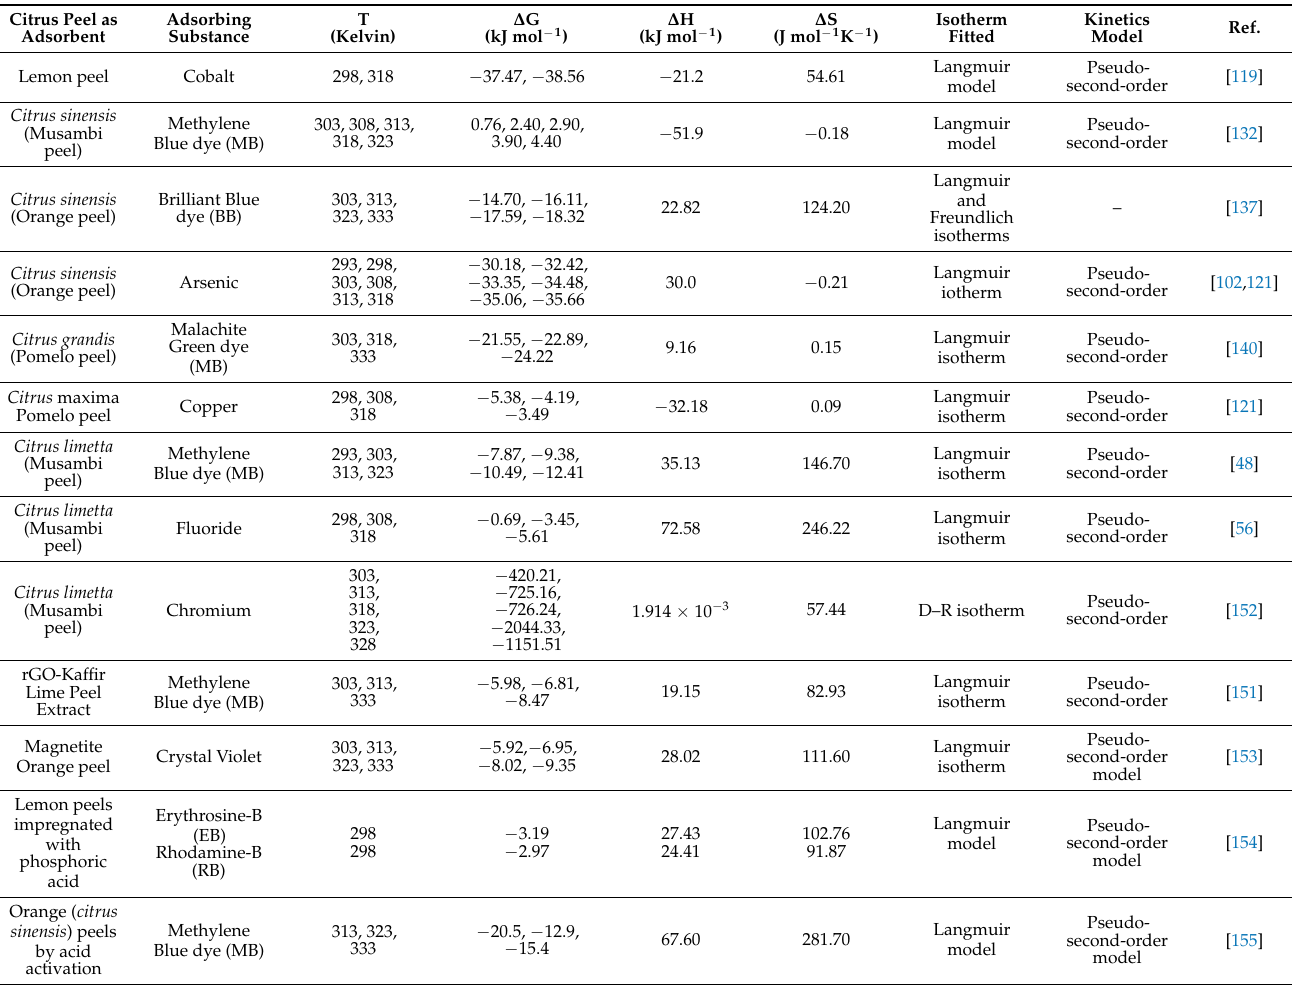
Table 5. Thermodynamics and kinetics studies of various dyes and ions on citrus peel as